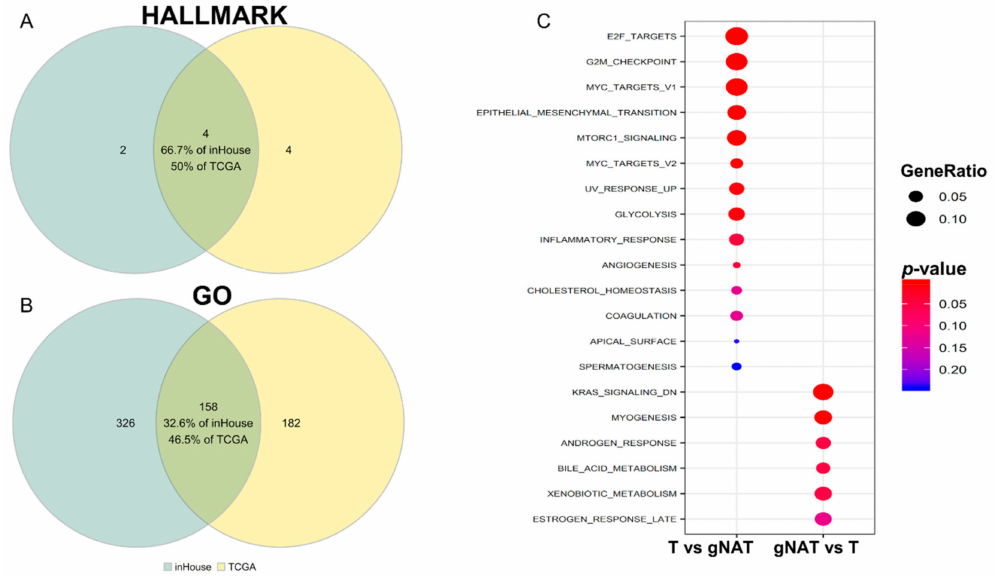
Figure 5. Distribution and description of enriched hallmark and GO gene sets in gNAT vs. Tumor between inHouse and TCGA dataset. ( A ) depicts the hallmark results, ( B ) depicts the GO results, ( C ) depicts GSA results. The p -value in red-blue color scale. Gene ratio in dot size scale. In order to confirm the reliability of the inHouse RNAseq, we processed our 18 samples by